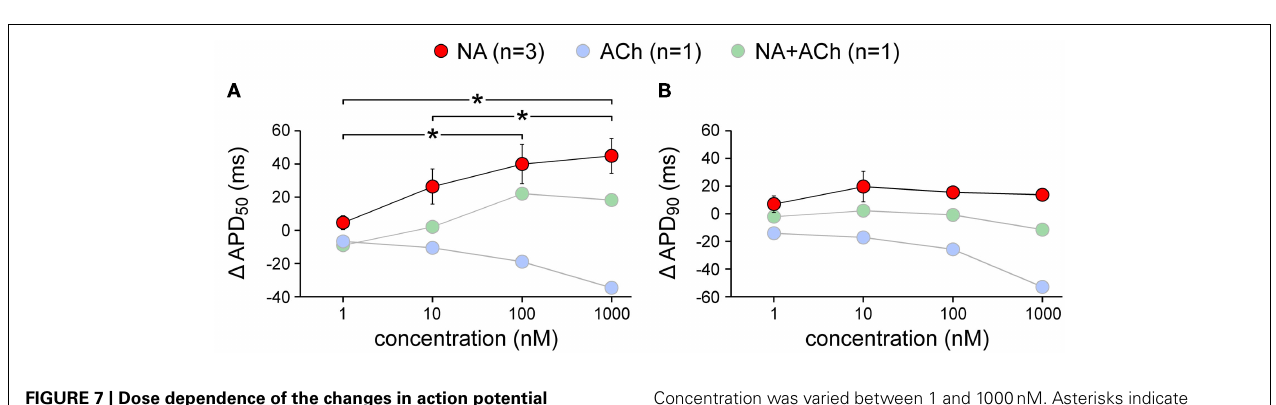
FIGURE 7 | Dose dependence of the changes in action potential duration of isolated rabbit left atrial myocytes in response to noradrenalin (“NA,” red symbols), acetylcholine (“ACh,” blue symbols), or a combination of both (“NA + ACh,” green symbols).